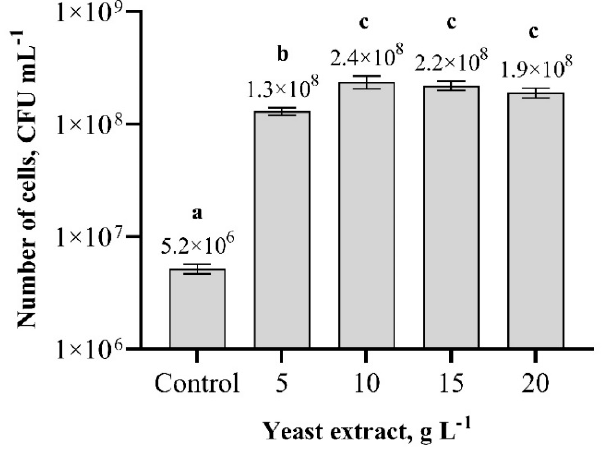
Figure 4. Effect of different concentrations of yeast extract on Paenibacillus sp. MVY-024 biomass production. The values marked with the same letter have no significant difference at p ≤ 0.05.